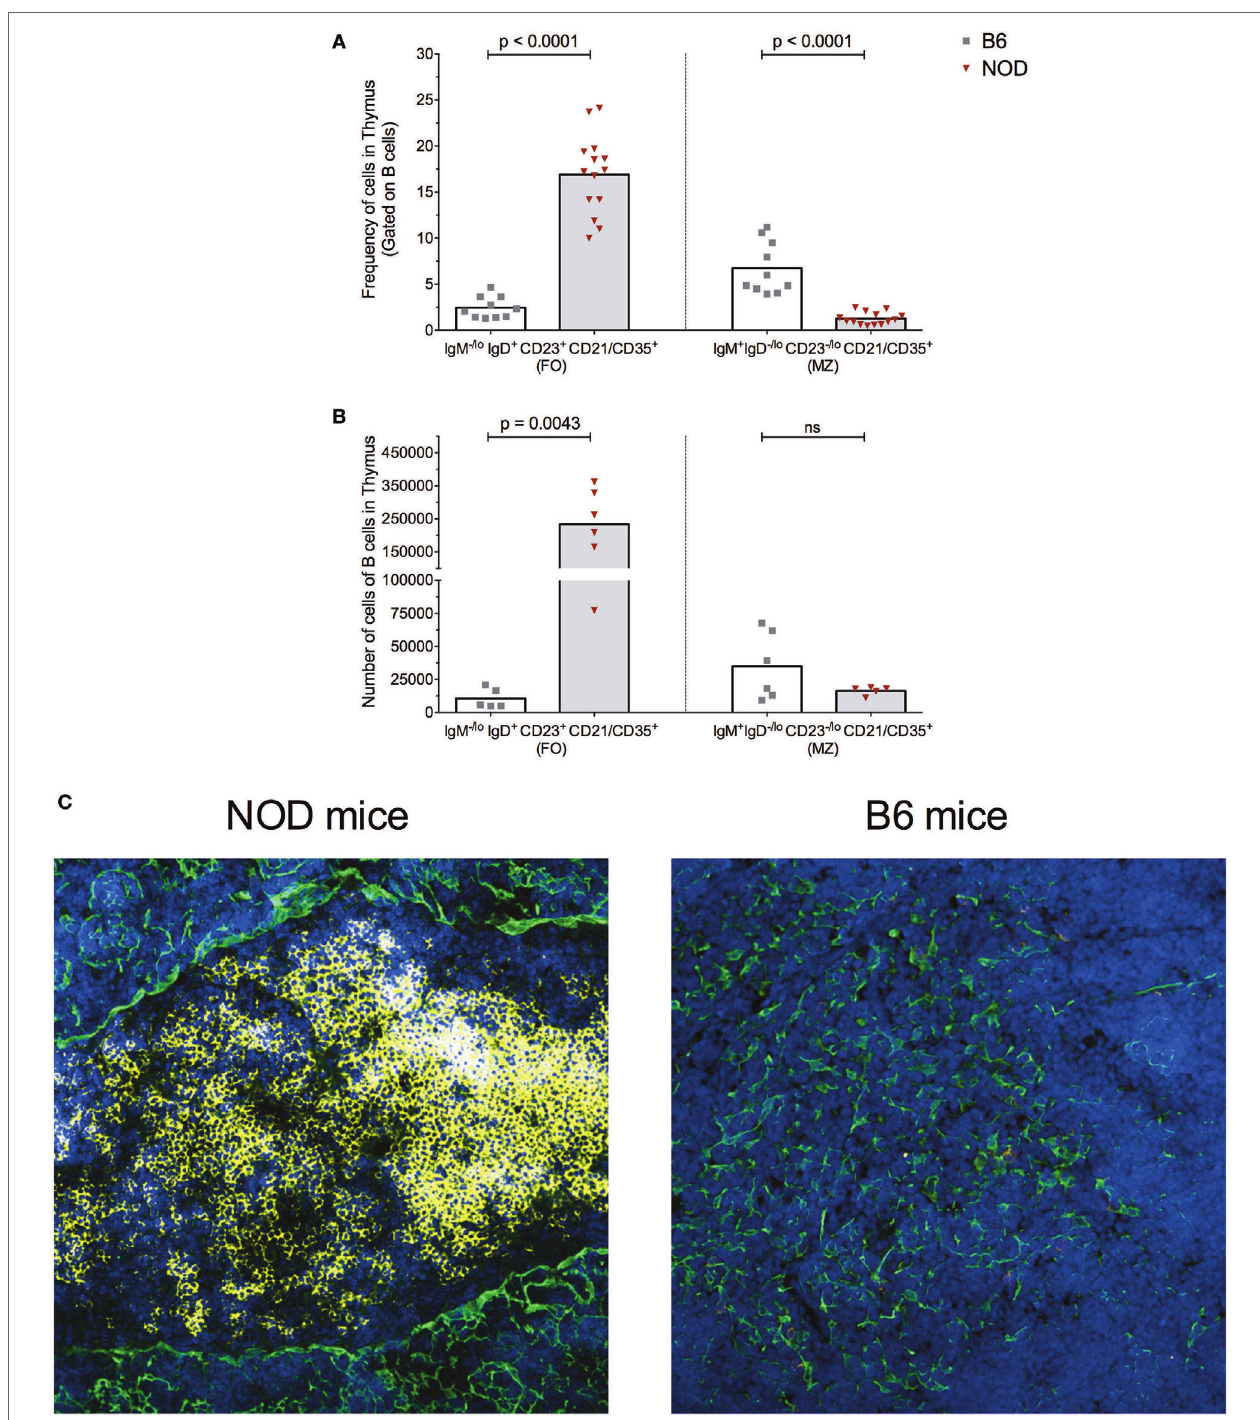
FigUre 2 | B cells form follicle-like structures at the cortical-medullary junction in non-obese diabetic (NOD) thymi. Flow cytometric analysis of the (a) frequency of B cells displaying a follicular (FO) or marginal-zone (MZ) phenotype in the thymus of B6 ( n = 10) or NOD mice ( n = 13) and (B) absolute number of B cells displaying FO or MZ phenotypes in the thymus of B6 ( n = 5) or NOD mice ( n = 6). Comparisons made between aged-matched, female 11- to 14-week-old mice in a single cell, live gate. Data acquired from at least two independent experiments and are presented as scatter plot; P values were calculated using the Mann–Whitney U -test analysis; ns, not significant. (c) Representative confocal immunofluorescence microscopy images of thymi sections examined for B220 (yellow), cytokeratin V (green) expression, and the DNA-intercalating dye DAPI identified nuclei (blue) from 11-week-old female NOD or B6 mice. A total of 14 sections from eight NOD mice and a total of six sections from three B6 mice were analyzed, and there was consistency in the data obtained from the appropriate strains of mice. Confocal fluorescent images were obtained with a Plan-Apochromat 20 × objective.